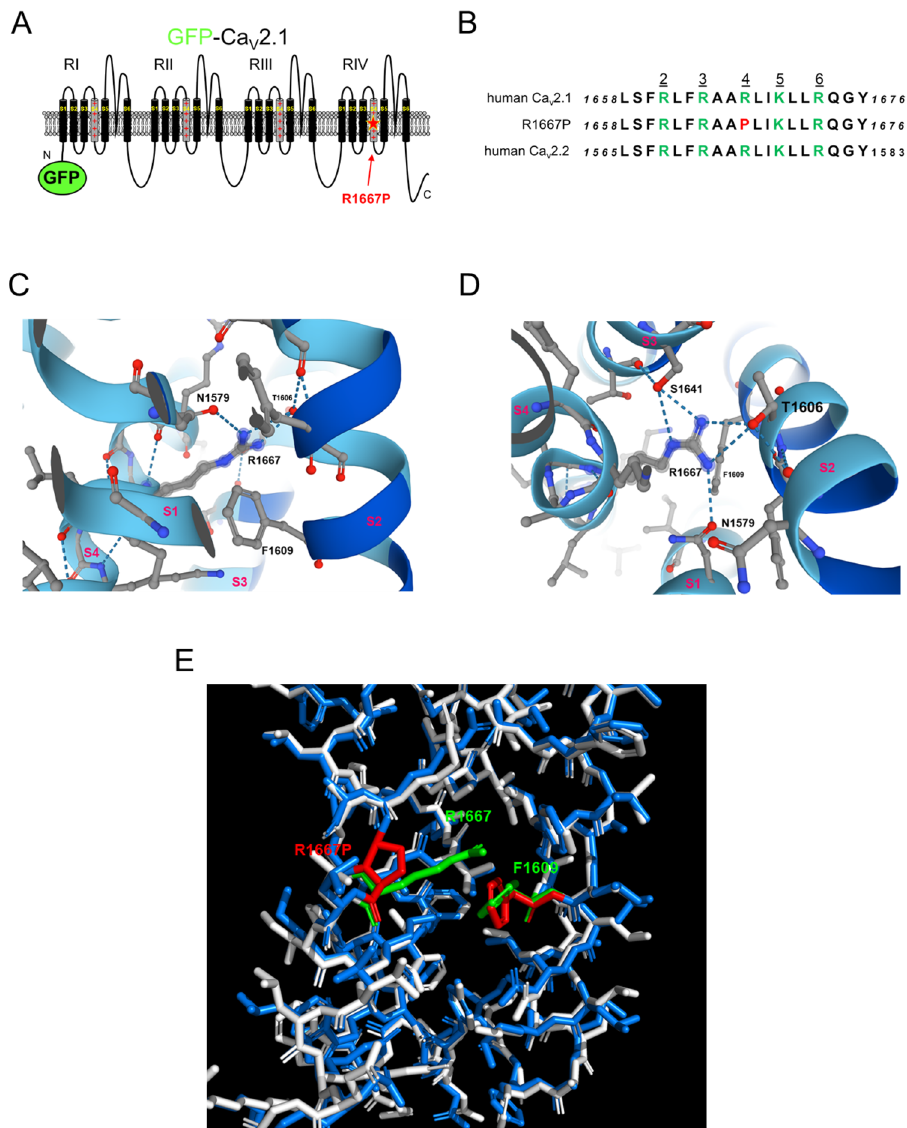
Figure 1. The R1667P mutation occurs at the R4 position of the Repeat IV S4 voltage-sensing α-helix. ( a ) Schematic representation of Ca V 2.1 with Green Fluorescent Protein (GFP) fused to the amino-terminus (GFP-Ca V 2.1). The R to P substitution at residue 1667 is indicated by the red star. ( b ) Sequence comparison of the Repeat IV S4 helices of all known human Ca V 2.1 variants ( cf . accession no. NP_001120693.1), human Ca V 2.1 with the R to P substitution at the R4 position and human Ca V 2.2 (accession no. NM_001243812). Basic residues in positions R2-R6, as defined by Ca V 2.2 Cryo-EM structure 10 are shown in green and the R4 R to P substitution is shown in red. ( c , d ) AlphaFold2 modeling of the voltage-sensing module of Repeat IV of human Ca V 2.1 58 . The S1–S4 helices are viewed from the lateral aspect ( c ) and from an extracellular ( d ) vantage points. Potential hydrogen bonds between R1667 and N1579 in S1, T1606 in S2, and S1641 in S3 are indicated by the blue dashed lines. F1609 (i.e., the gating charge transfer center) is also labelled. Panels ( c ) and ( d ) were published with permission https:// creat iveco mmons. org/ licen ses/ by/4. 0/ ( e ) Missense 3D model showing the impact of the arginine to proline substitution at position 1667. The mutant stick structure (blue) is overlaid on the wild-type stick structure (white) with R1667 shown in green and the R1667P substitution shown in red. In both cases, F1609 is shown; this residue is colored green and red in the in the wild-type and mutant structures,